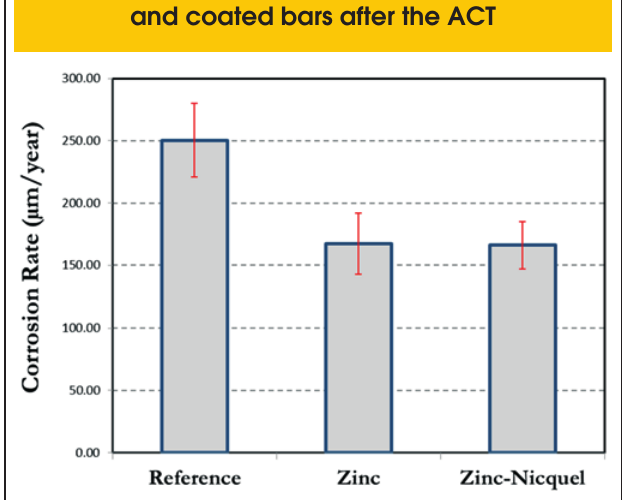
Figure 8 – Corrosion rates for the conventional and coated bars after the ACT